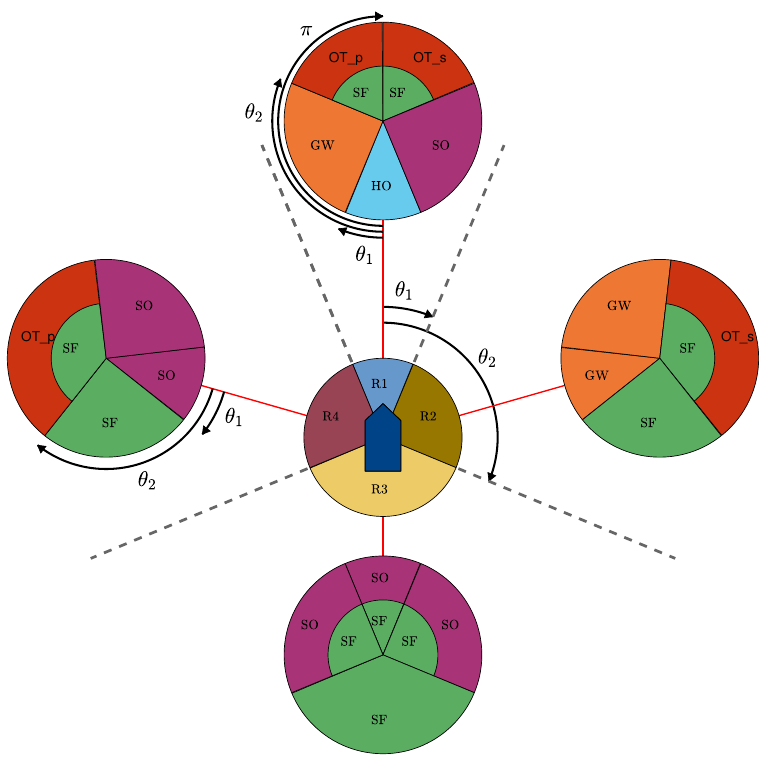
Figure 4: Graphic representation of the classification algorithm, where the position of the OS is at the center of the middle circle. In situation sectors with two encounter classifications, the outer one is chosen when the involved vessels have a closing range, while the inner one is chosen for increasing range. course to starboard so that each shall pass on the port side of the